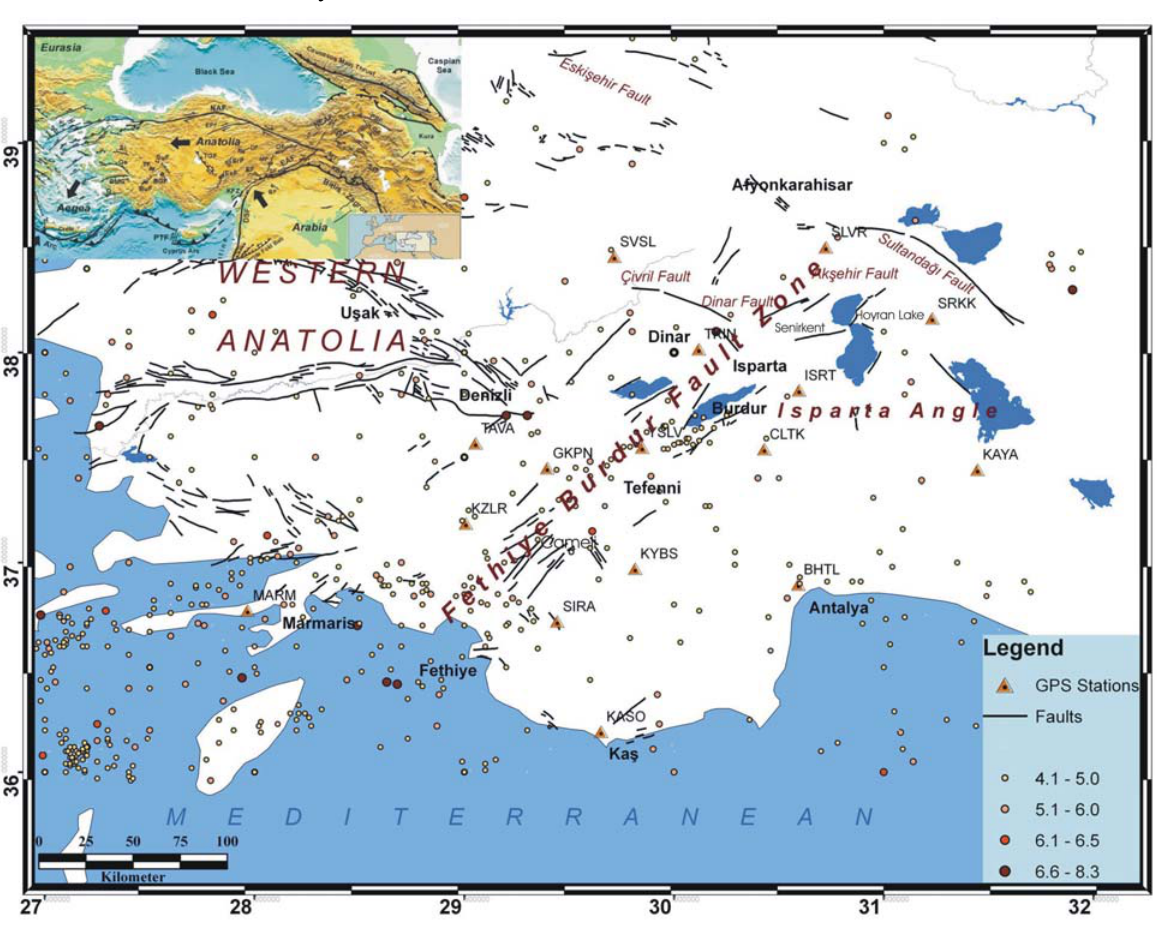
Figure1 . Outline tectonic map of the easternmost Mediterranean area, showing the main neotectonic lineaments and the main structural units in the text. Seismicity of the Western Anatolia in the last century with M s >